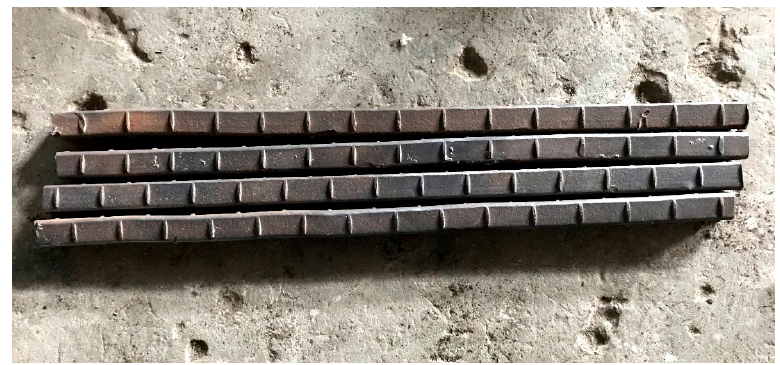
Figure 5. The vintage square rebars.